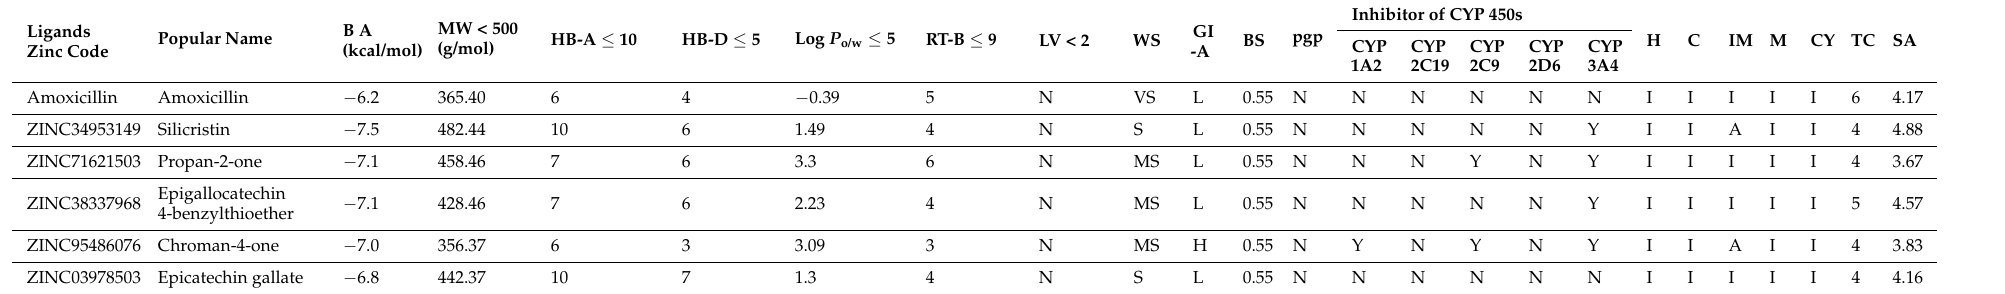
Table 1. Binding affinity of the top-five phenolics against the active site of PBP2a and their ADMET